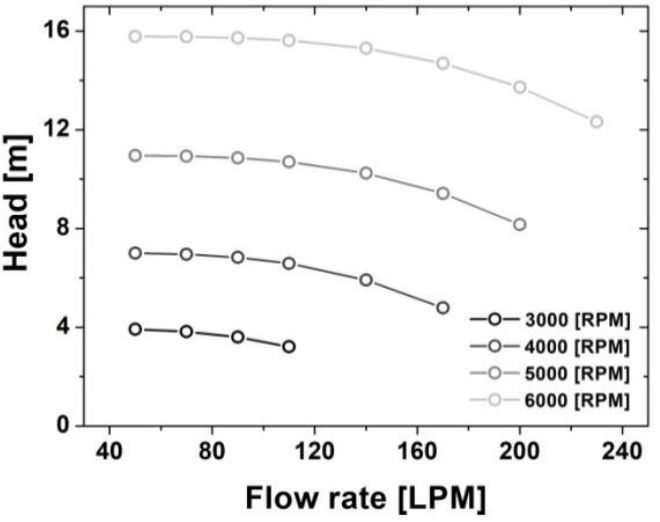
Figure 2. The performance curve of the cooling pump.